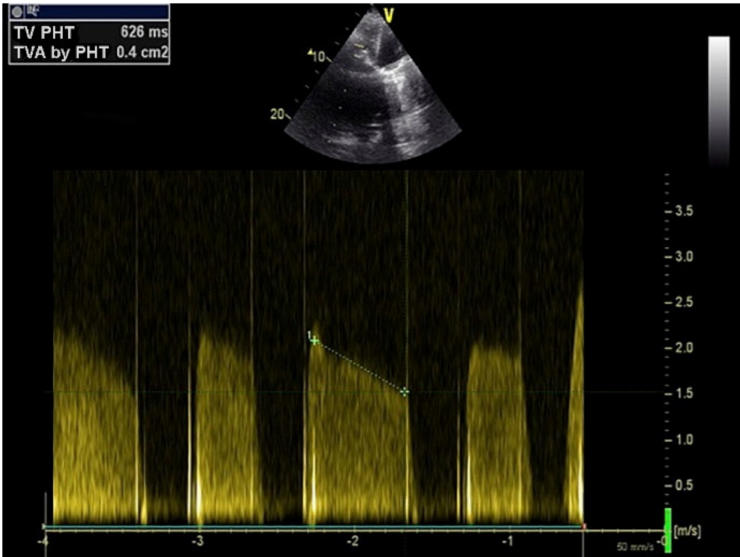
Figure 1. Transoesophageal echocardiography mid-oesophageal four-chamber incidence showing severe tricuspid stenosis with pressure half time (PHT) 626 ms and tricuspid valve area (TVA) 0.4 cm 2